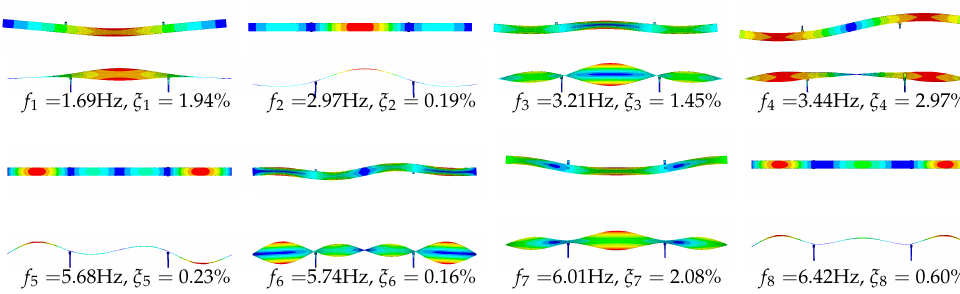
Figure 11. Top and side view of the first eight modes of the Eeklo footbridge (cfr. digital twin [52]).